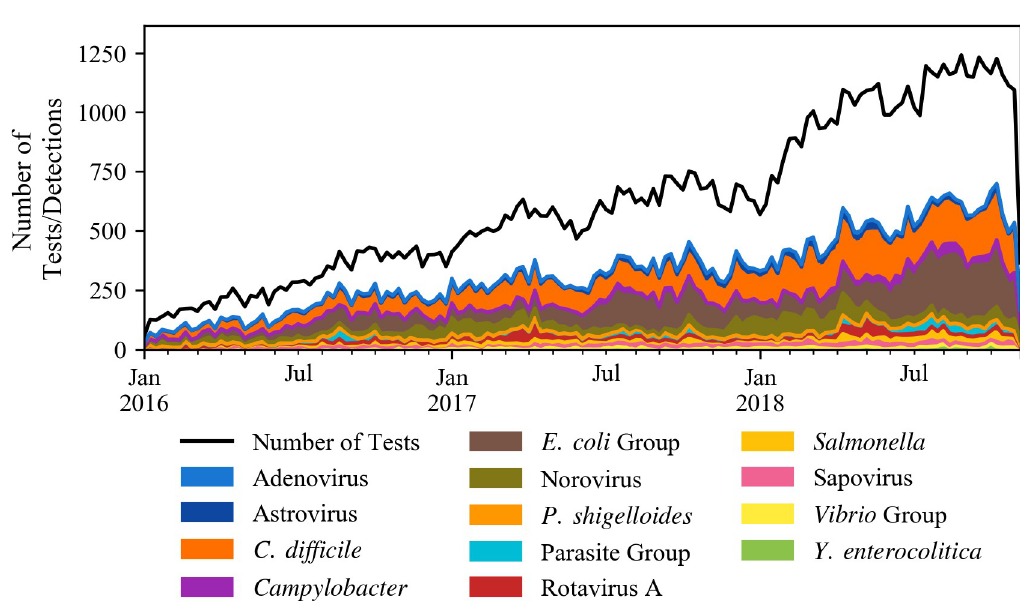
Fig 1. Number of BioFire Trend GI tests collected from the selected laboratories (N = 91,401) and detected pathogens from January 2016 through October 2018 (N = 50,192).